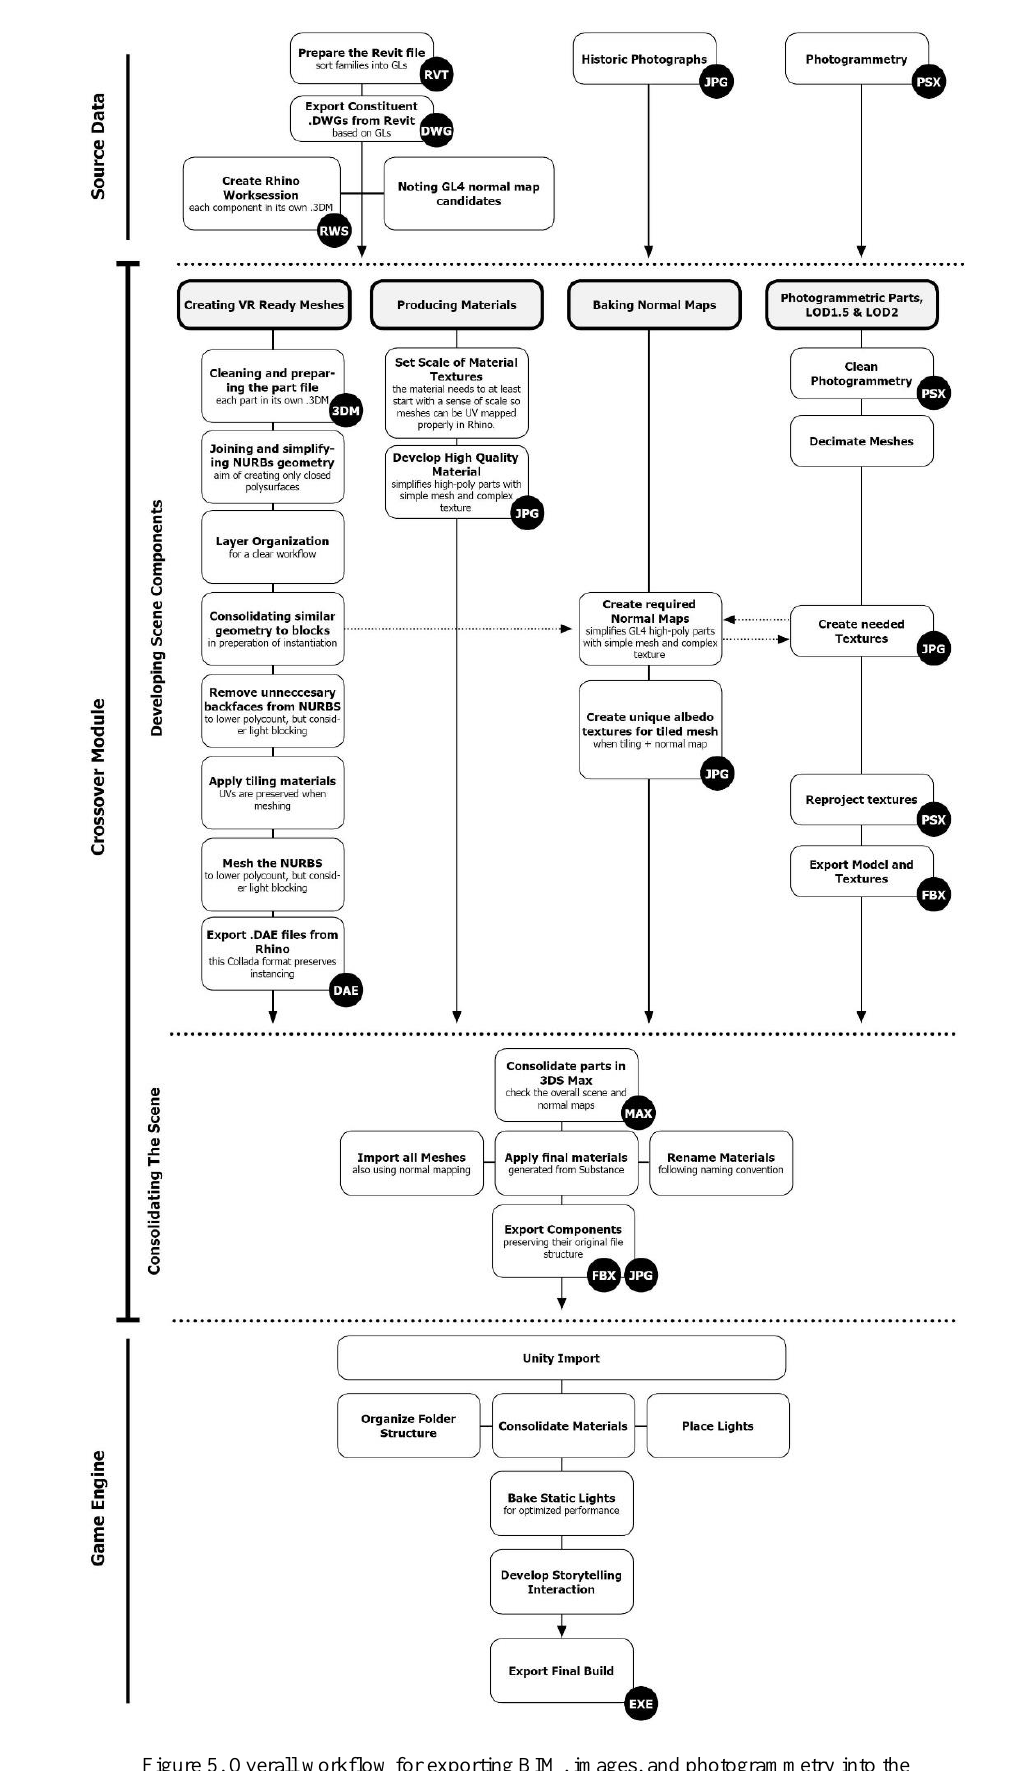
Figure 5. Overall workflow for exporting BIM, images, and photogrammetry into the Unity Game Engine. Note that some process can develop in